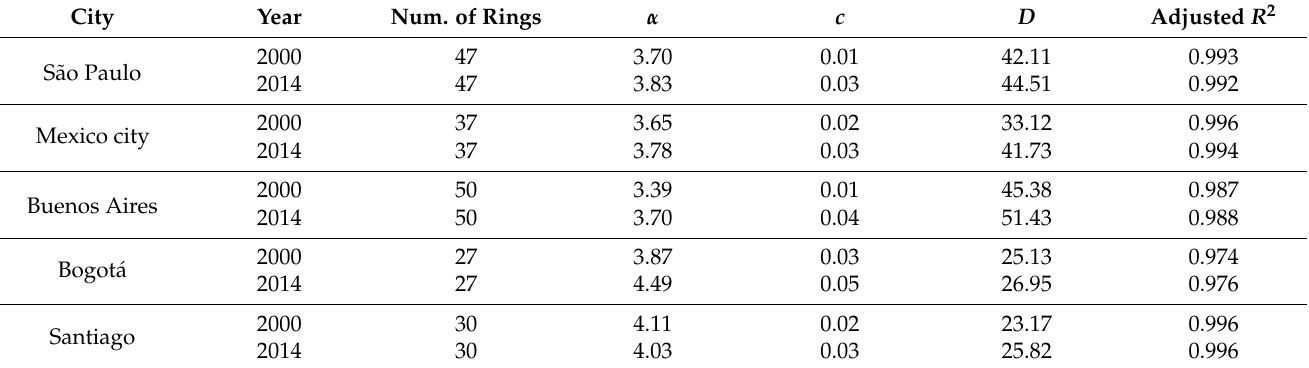
Table 2. Parameters of the inverse S curve for five Latin American cities in 2000 and 2014. City Year Num. of